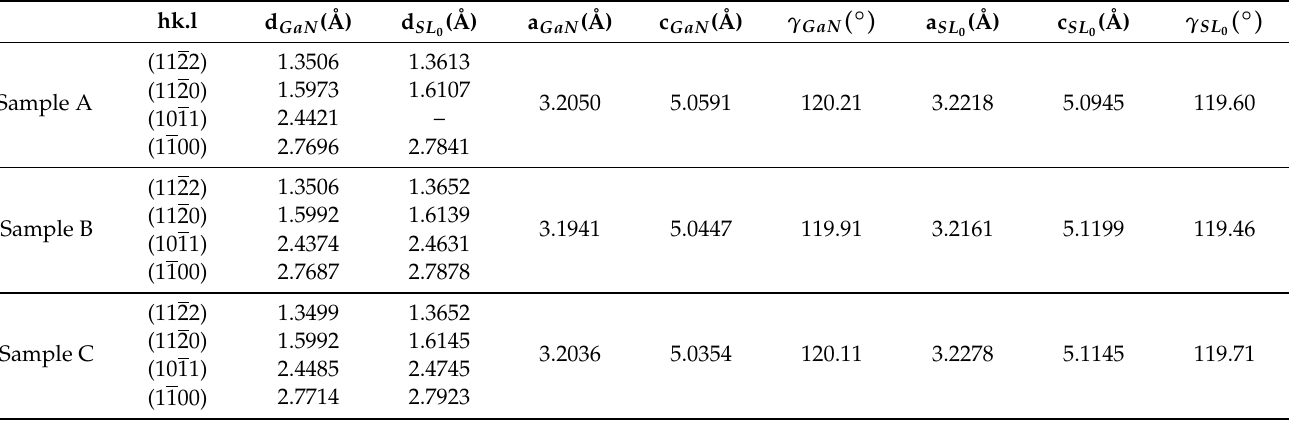
Table 2. Lattice parameters of the GaN underlayers and the superlattice structures of Sample A, Sample B and Sample C.